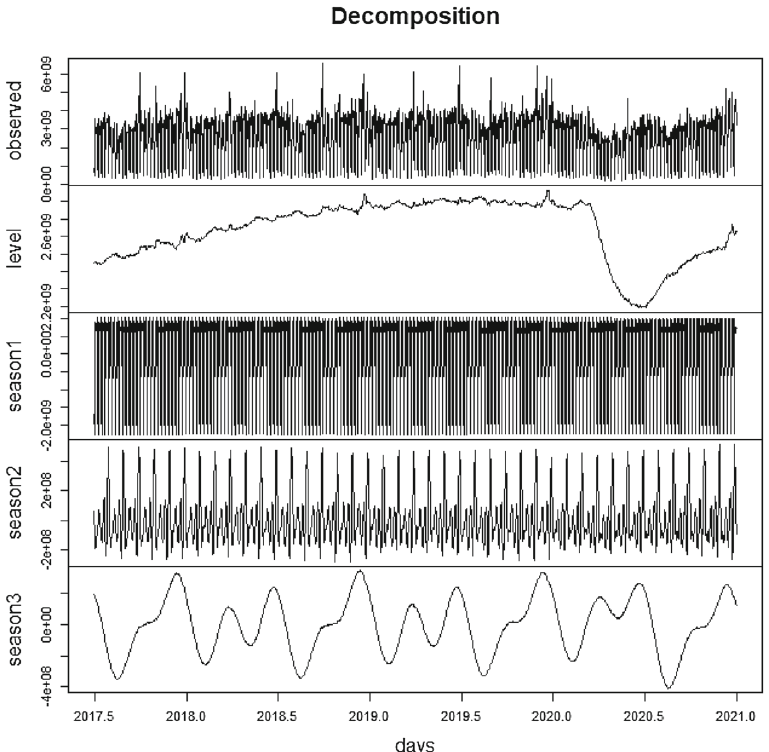
Fig. 4 Stochastic decomposition of the daily SII sales. Note level refers to trend, season1 refers to weekly seasonality, season2 refers to monthly seasonality and season3 refers to annual seasonality